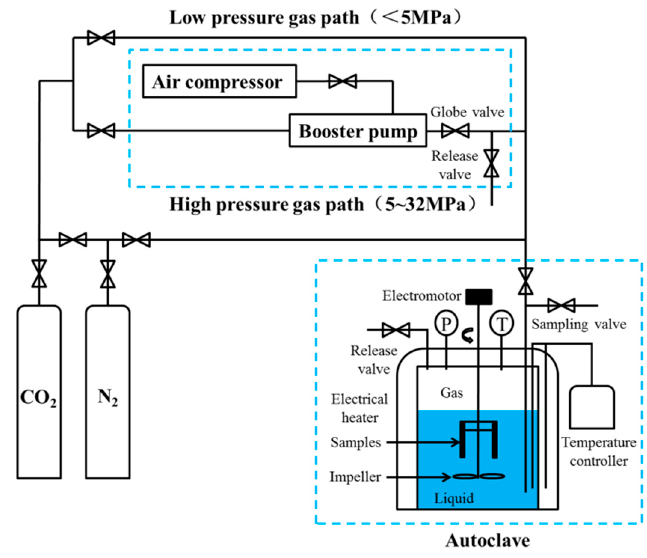
Figure 1. Flow chart of steel corrosion rate evaluation system (Mass loss method).